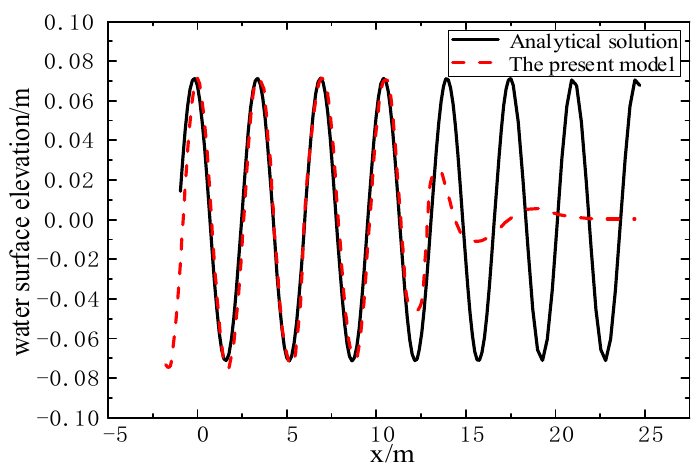
Figure 3. A comparison of the free surface of the present wave model with the analytical solution.